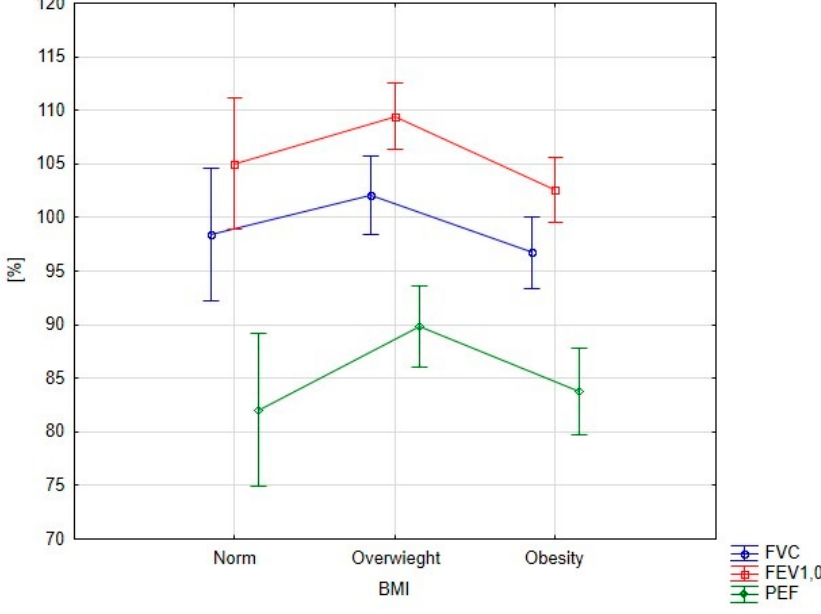
Figure 1. Spirometry parameters depending on body mass index (BMI).